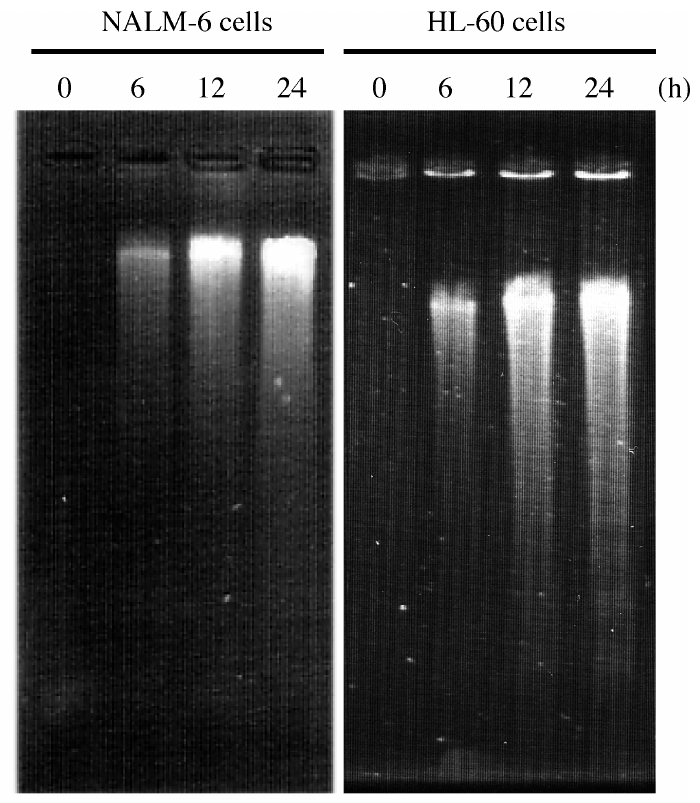
Figure 6. Effect of cEPA on the induction of apoptosis. The total DNA was extracted from NALM-6 values of cEPA (i.e., 37.5 and 12.5 μ M, respectively) cells and HL-60 cells after exposure to the LD 50 for the indicated times, and then each DNA extract was applied to the gel. Nucleosomal DNA fragmentation was analyzed by agarose gel